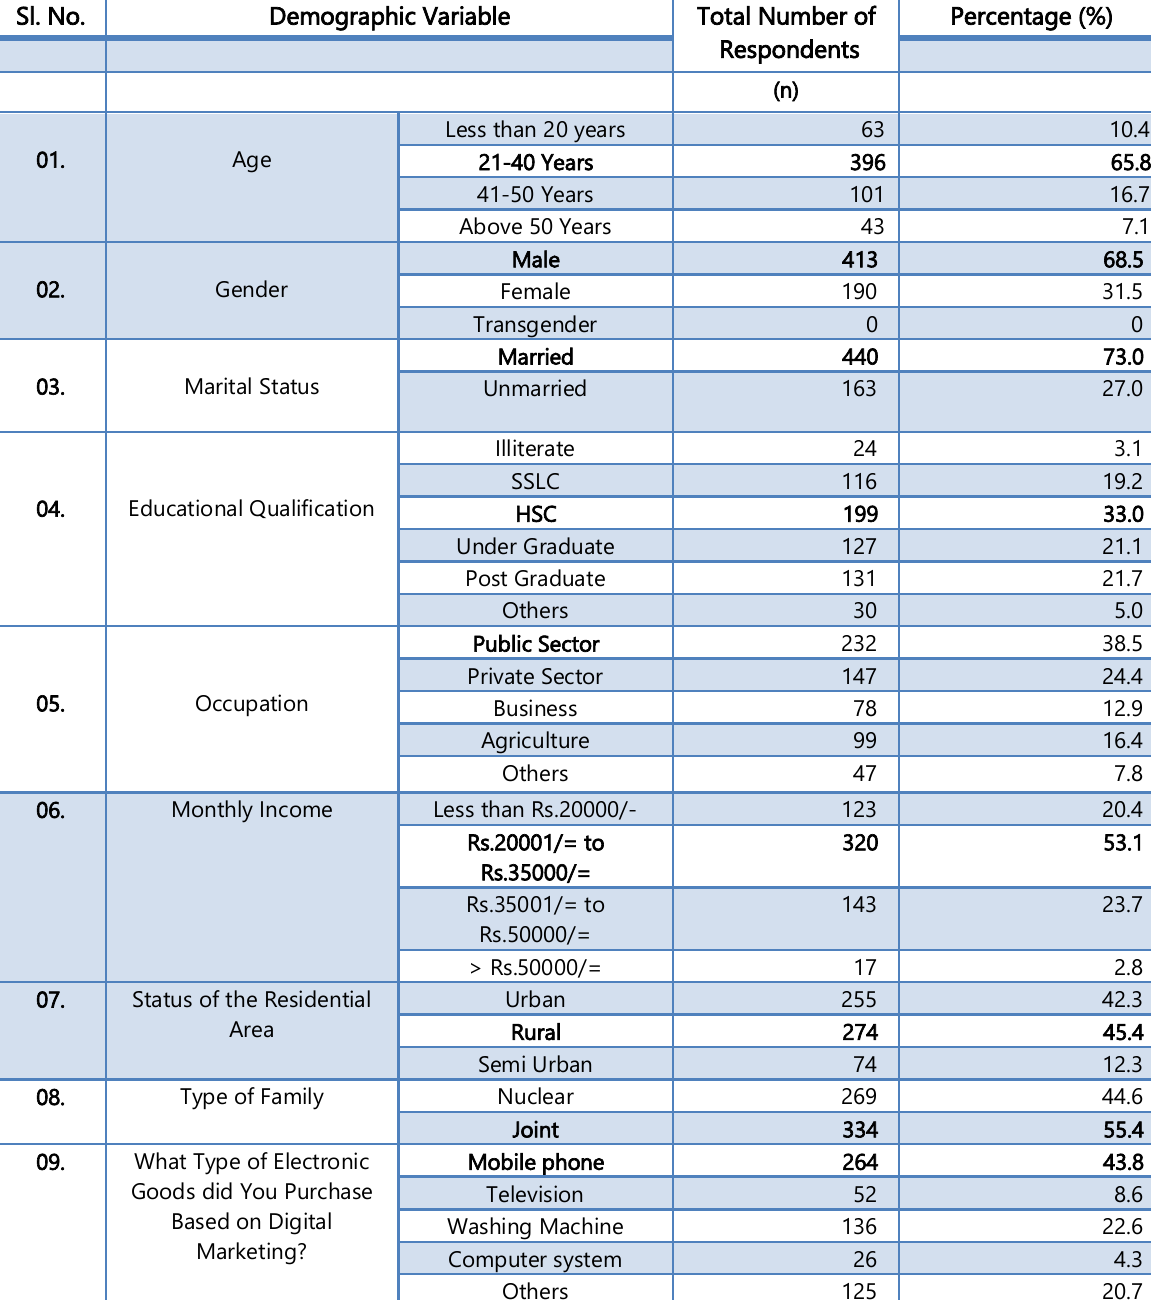
Table 3: Details of the Demographic Details of the Respondents (Source: Authors‟ depiction) Sl. No.